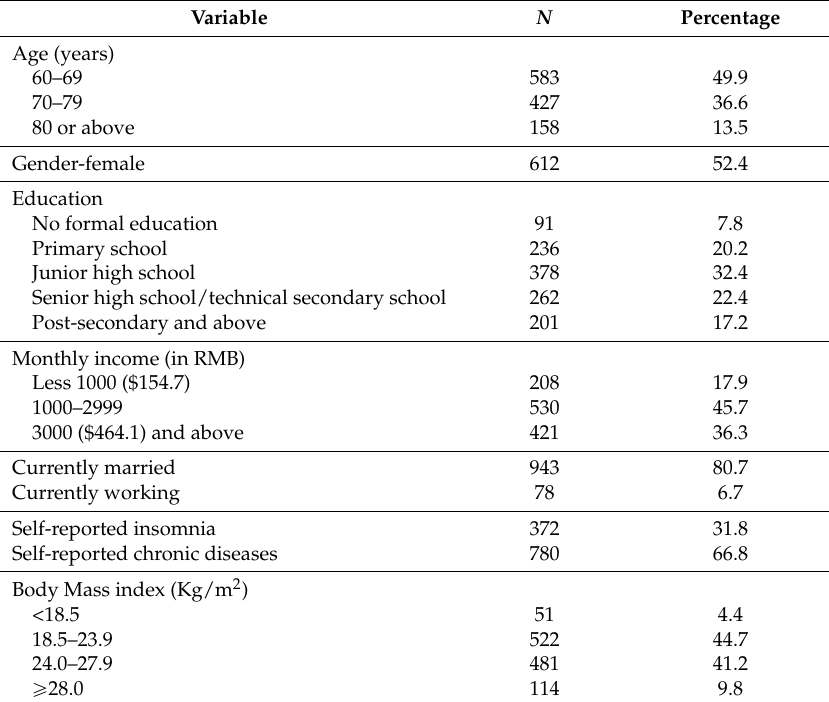
Table 1. Demographic characteristics of the sample ( n =